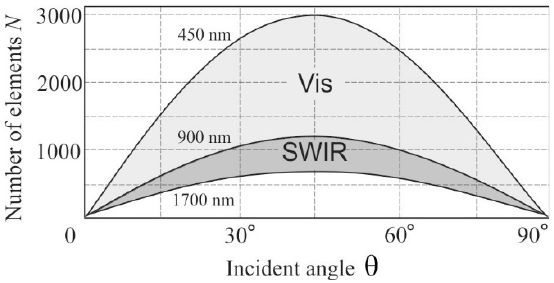
Figure 4. Angle dependence of resolvable element number for visible and short wave infrared (SWIR) ranges for TeO 2 crystal cell with D AOTF = 9 mm.